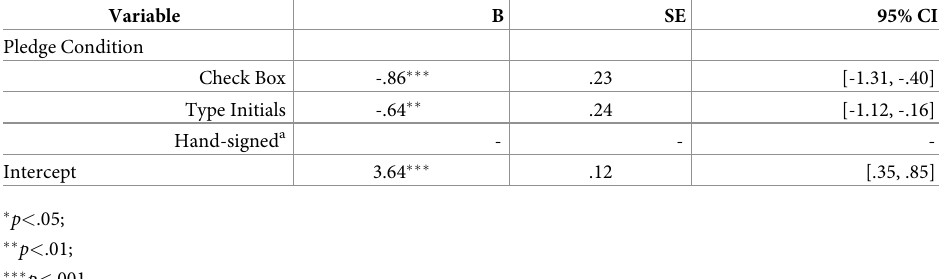
Table 1. Poisson regression analysis on commitment behavior, Pilot Study